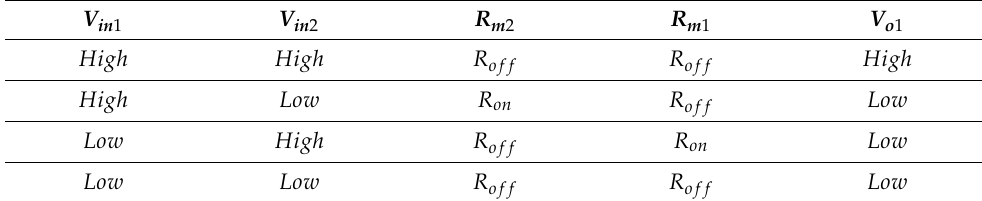
Figure 5. Two memristors connected as ( a ) an AND-gate and ( b ) an OR-gate. Table 2. The different states of each memristor for Figure 5a.